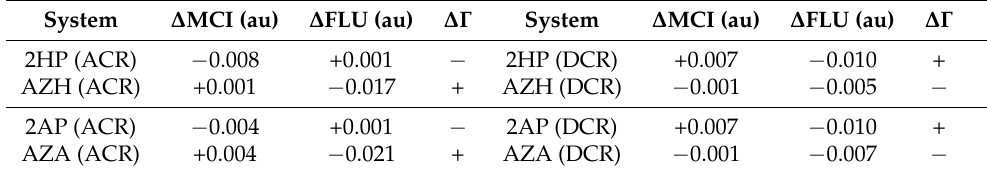
Table 4. Change in the MCI and FLU aromaticity indices, along with the change in aro-